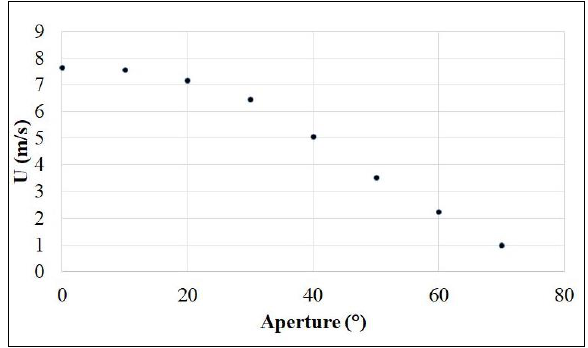
Fig. 19. The experimental line verification measurement result – the calculated